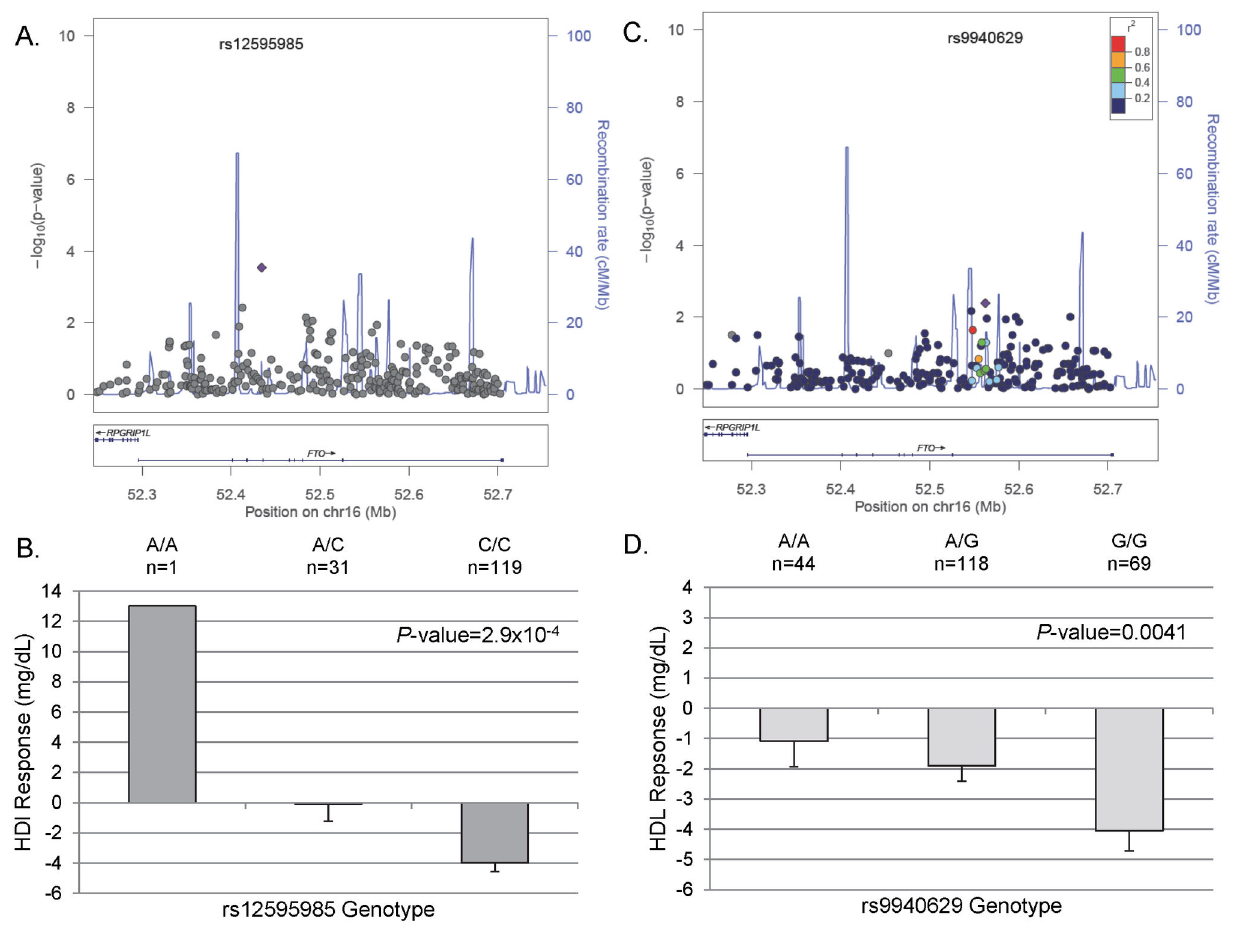
Figure 2. FTO Regional Plots and adjusted HDL-C response by genotype. (A) Regional Plot in PEAR African Americans. (B) HDL-C response in PEAR African Americans by rs12595985 genotype. (C) Regional Plot in PEAR whites. (D) HDL-C response in PEAR whites by rs9940629 genotype. Error bars represent standard